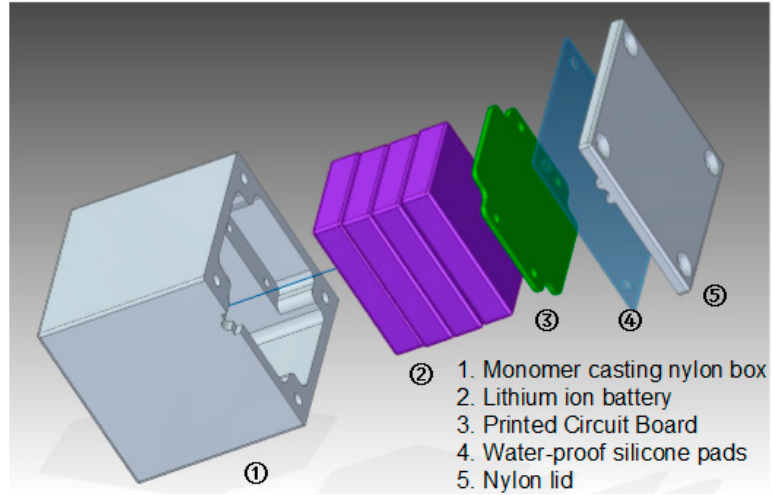
Figure 1. Acceleration sensing node.